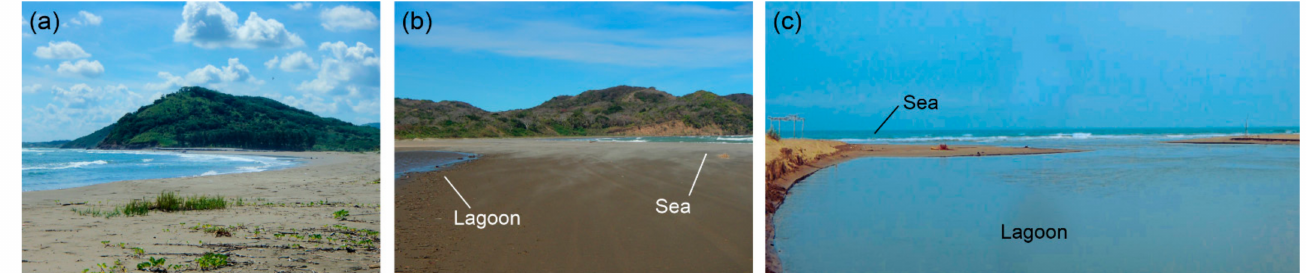
Figure 2. La Mancha: ( a ) beach; ( b ) the lagoon inlet closed by the sandbar in the dry season; ( c ) the open lagoon inlet in the wet